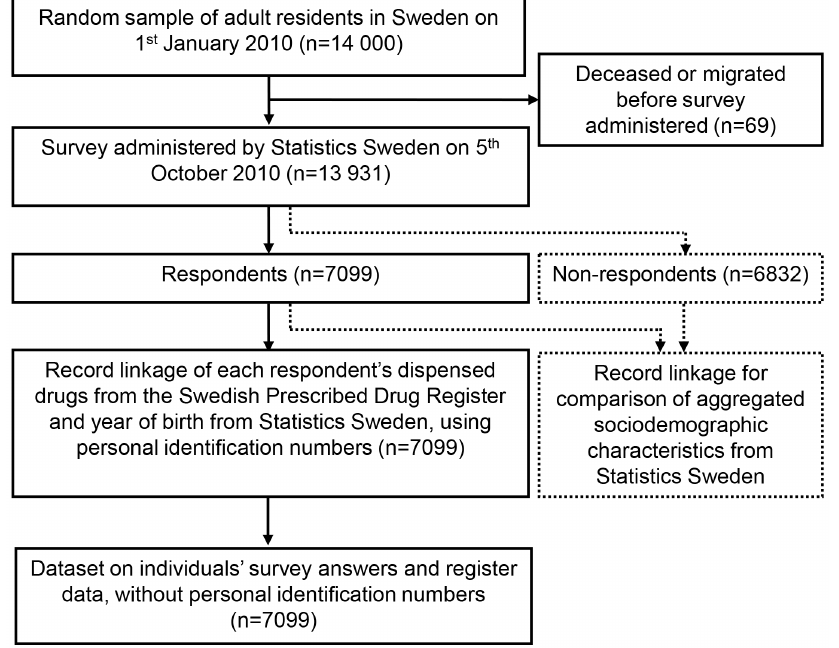
Figure 1. Study flow diagram.